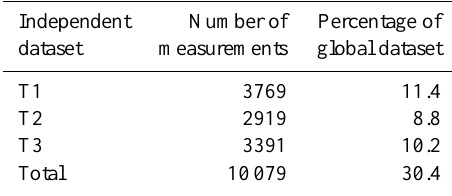
Table 4. Summary of the three independent datasets used to con- strain the general configuration of the SOMLO